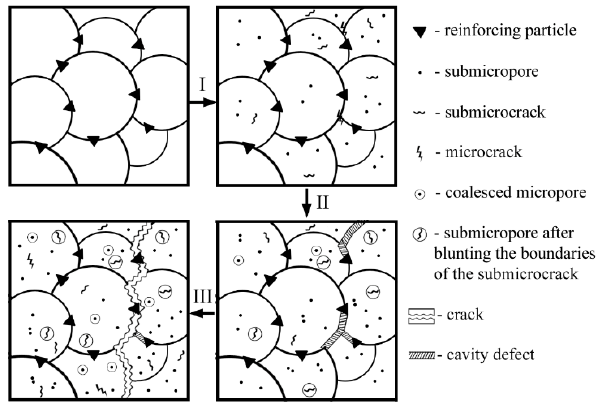
Figure 6. Schematic damage accumulation in the sintered metal matrix composite during plastic deformation.